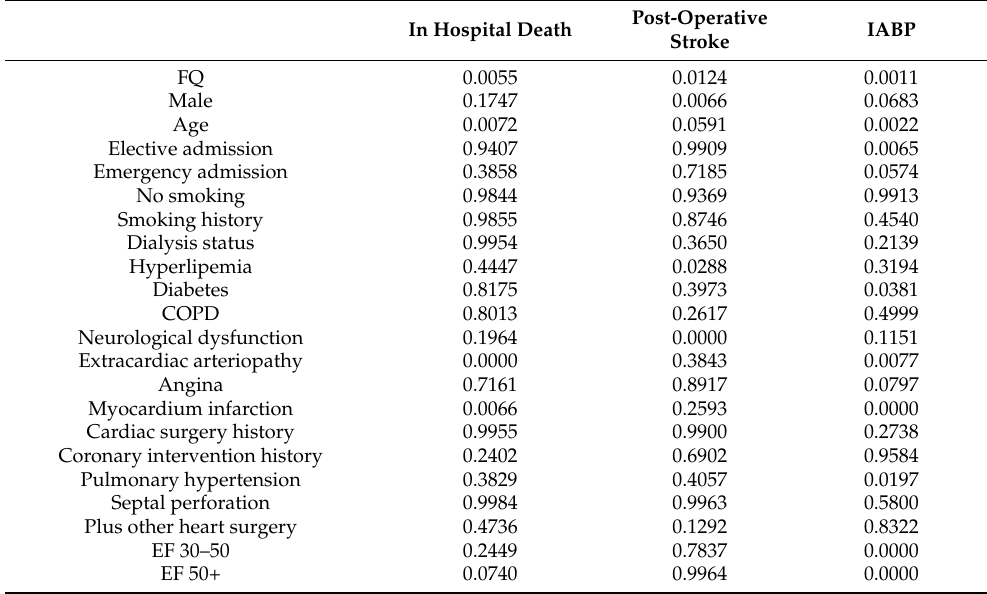
Table 5. Difference and their covariance of in hospital death, post-operative stroke, and IABP application of the matched cohort (logistic